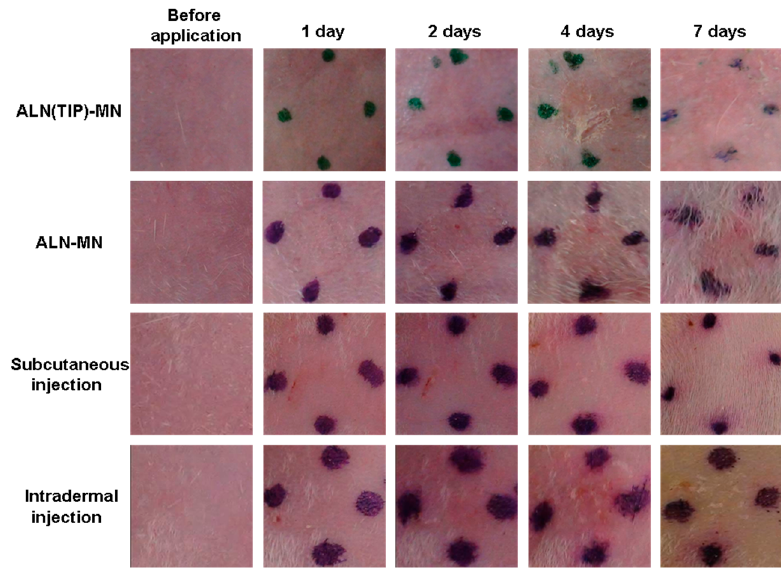
Figure 7. Skin irritation after administration of ALN with various methods. The macroscopic appearance of the skin was recorded daily before application of the ALN(TIP)–MN and after its removal over 7 days. The area surrounded with points shows the site where ALN was administered. Representative data are shown from one of three experiments.